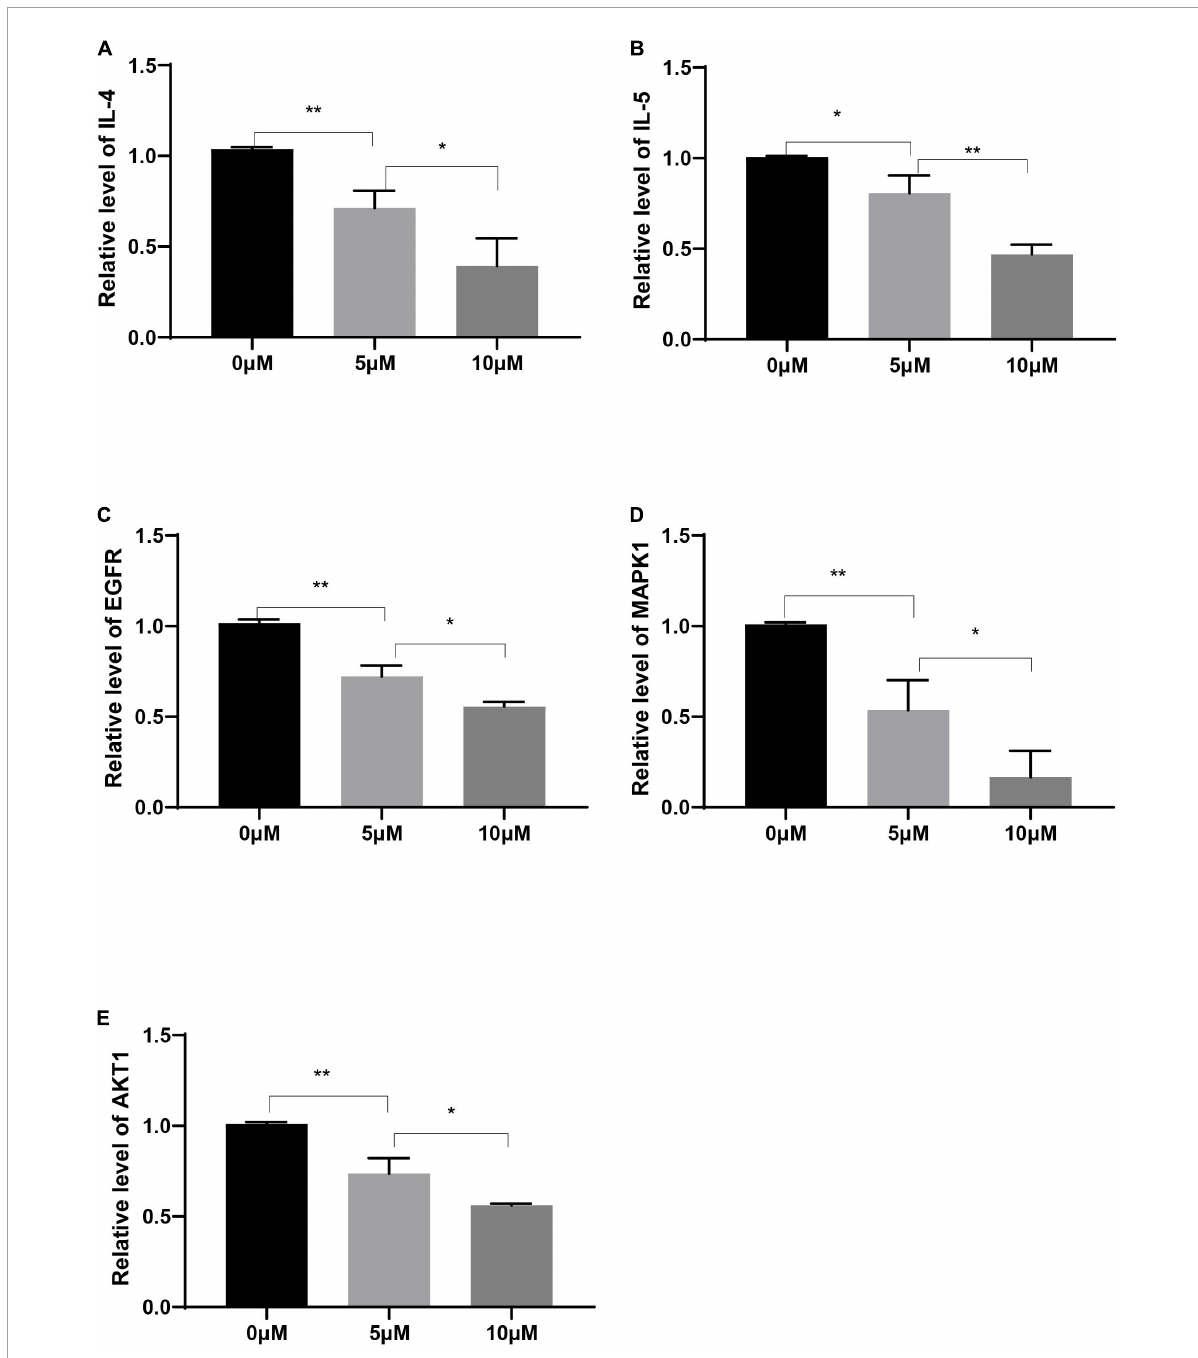
FIGURE9 Relative expression levels of IL-4 (A) , IL-5 (B) , EGFR (C) , MAPK1 (D) , and AKT1 (E) in Human PBMCs treated with decursin at 0, 5, and 10 µ M. * P < 0.05, ** P < 0.01; n = 3.